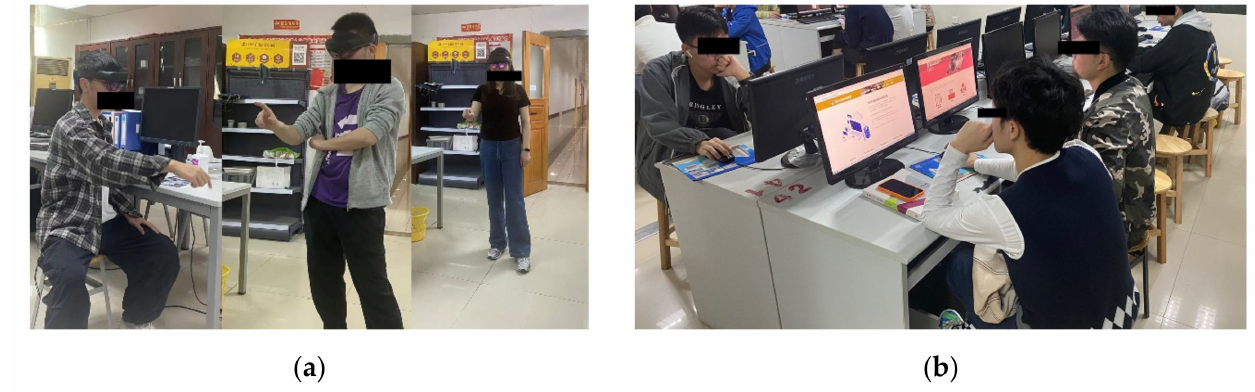
Figure 14. User experiment: ( a ) Groups A/B user test; ( b ) Group C user